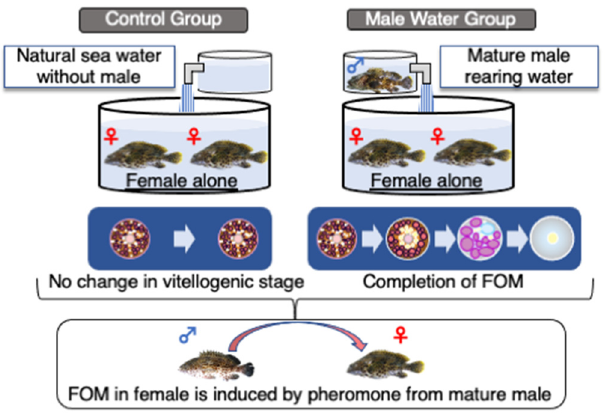
Figure 2. Induction of final maturation in females by pheromones released from mature males.